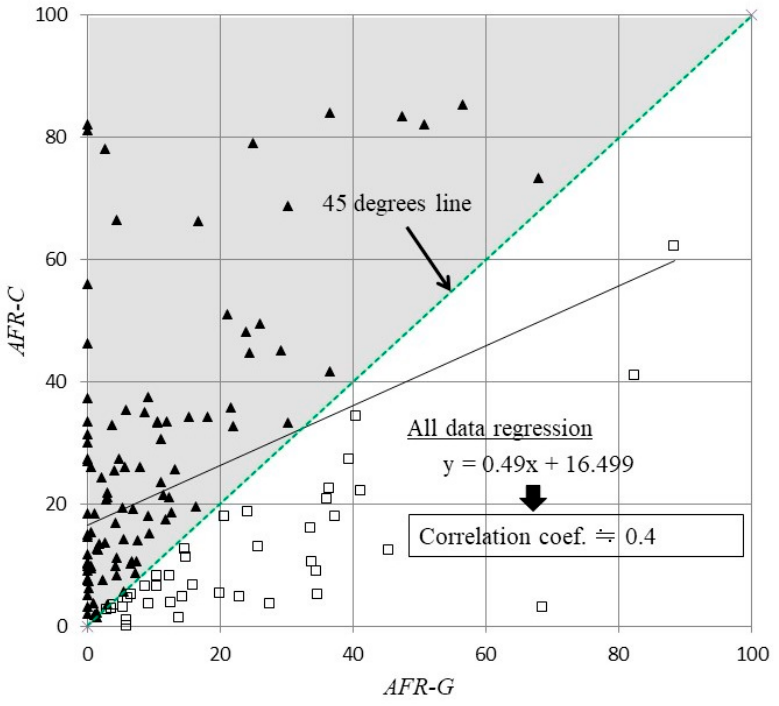
Figure 3. Correlation between AFR-G and AFR-C